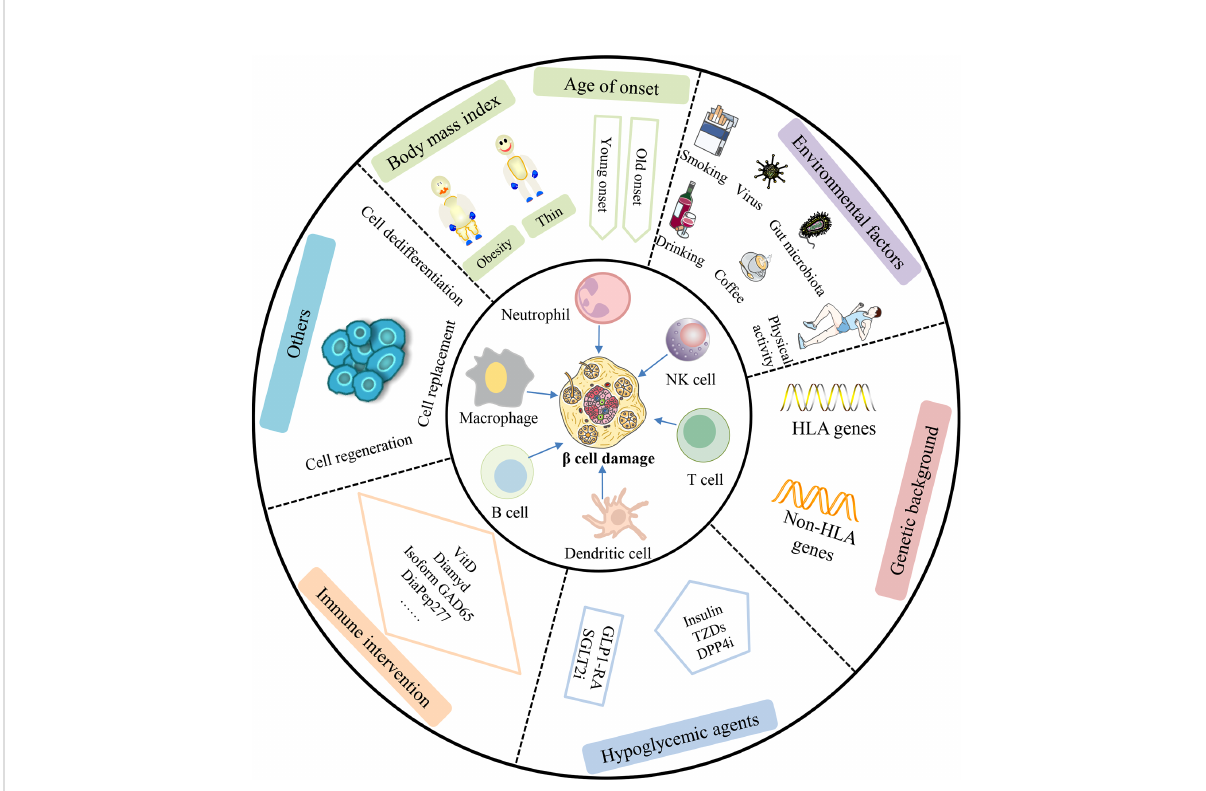
FIGURE 2 Comprehensive factors affecting b -cell protection and therapy in LADA patients. b -cell function in LADA patients can be affected by cellular, humoral, and innate immunity. Additionally, studies have shown that age of onset, body mass index, environmental factors, genetic background, hypoglycemic agents, and immune intervention can also play an important role in b -cell damage in patients with LADA. In the future, b -cell dedifferentiation, regeneration, and b -cell replacement may be a promising approach to cure LADA patients. NK cell, natural killer cell; TZDs, thiazolidinediones; DPP4i, dipeptidyl-peptidase-4 inhibitor; GLP1-RA, glucagon-like peptide-1 receptor agonist; SGLT2i, sodium-glucose cotransporter 2